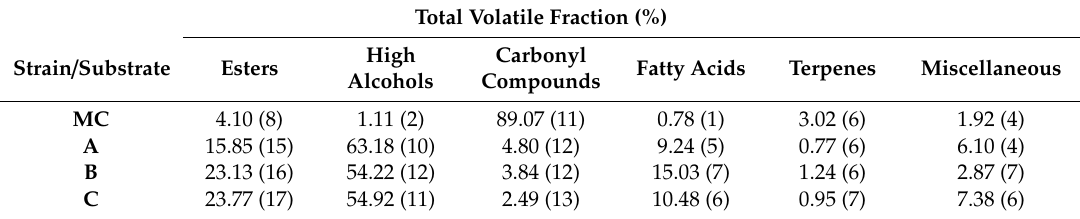
Table 2. Percentage (%) of VOMs for each chemical family to the total volatile profile (in brackets the standard deviation).